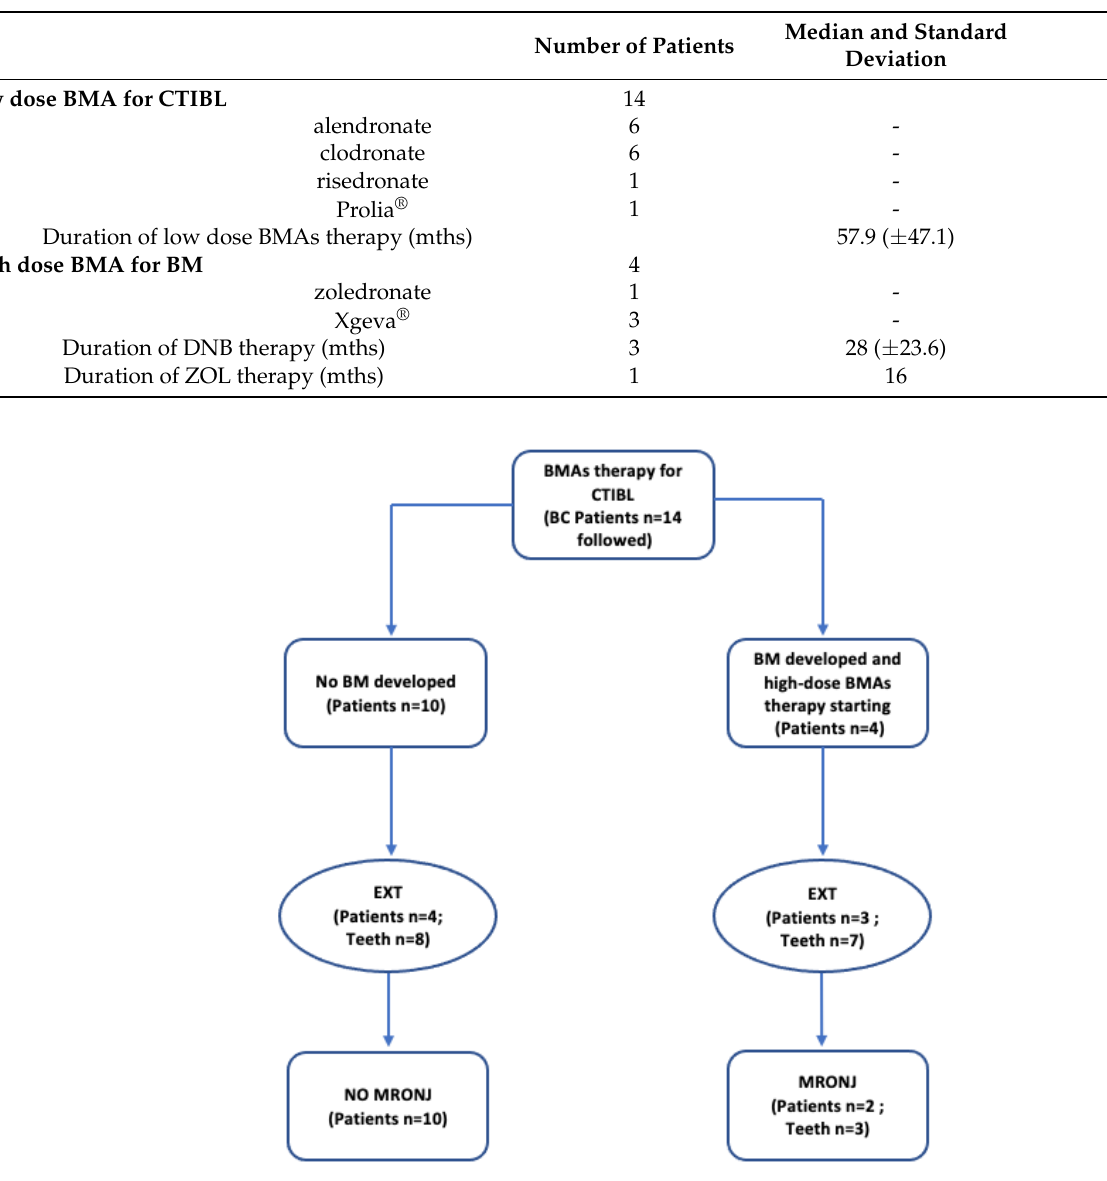
Figure 1. Flow chart of MRONJ occurrence. A relationship between BMAs therapy and MRONJ development after teeth extractions was diagnosed in 14 patients with breast cancer. Four patients